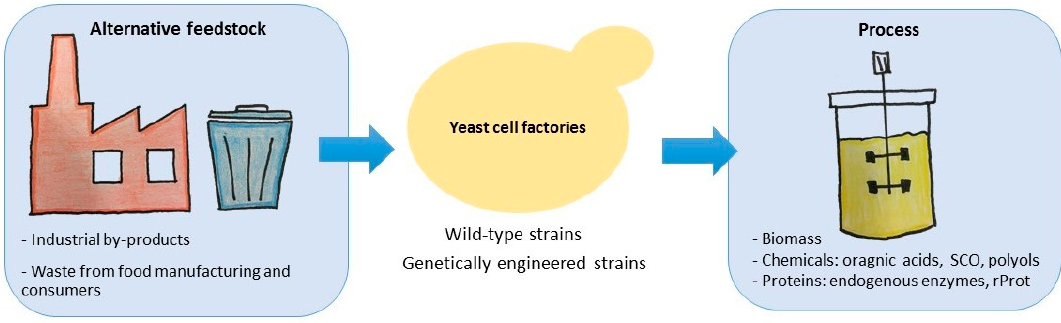
Figure 1. Schematic representation of the principles discussed in this review. Waste materials are used as alternative feedstocks for yeast cell factories, which use them to produce chemicals or proteins of